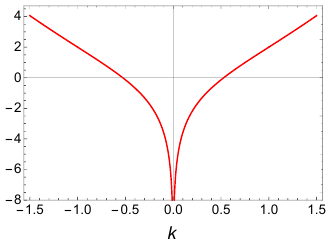
( x c (cid:0) sign( k )